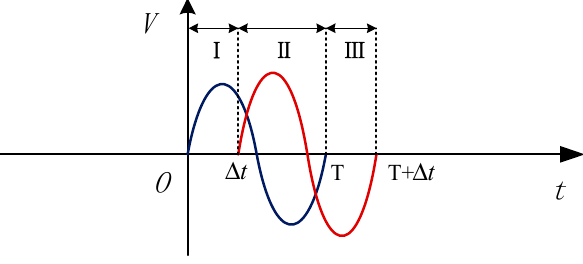
Figure 3. The three segments of the signal model for two aliasing debris.